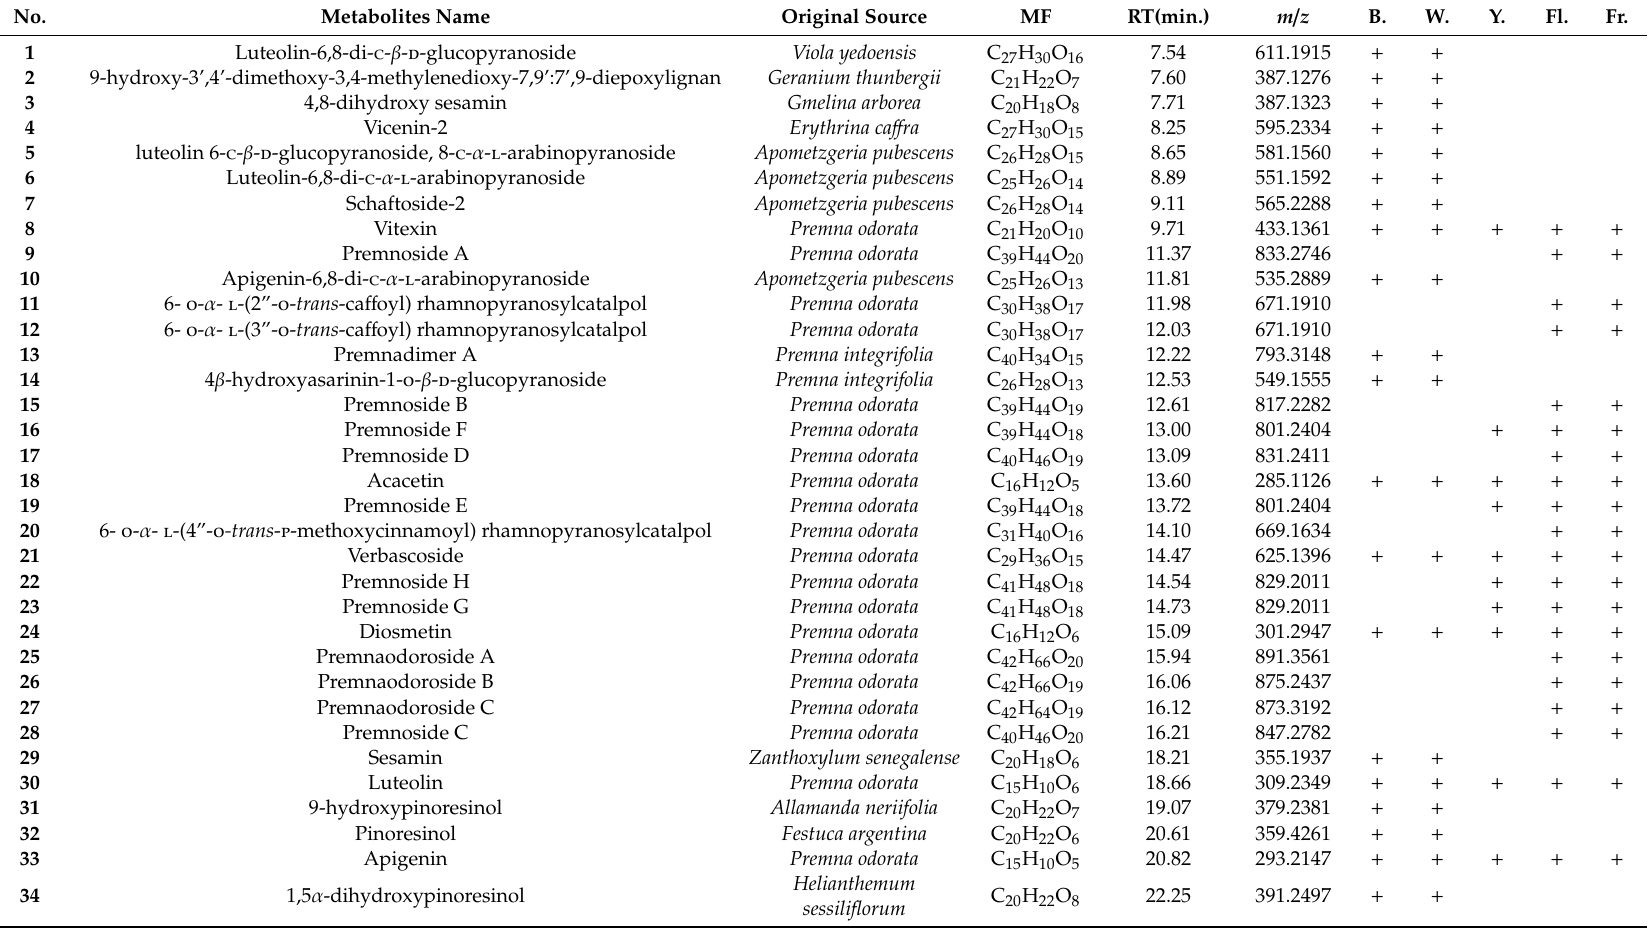
Table 1. The LC–HR–ESIMS dereplication results of the Premna odorata bark, wood, young stems, flowers, and fruits crude